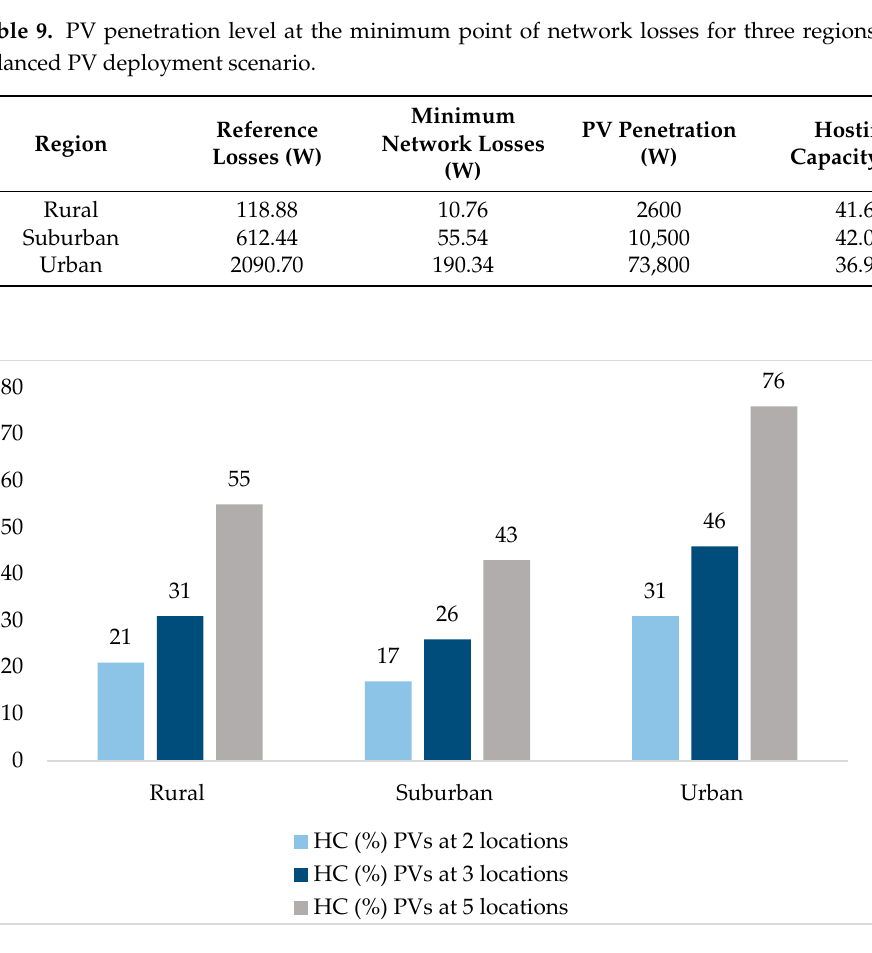
Table 10. Sensitivity analysis of economical hosting capacity in the cost analysis of three Finnish distribution networks by changing the cost of energy losses (ce) and load growth (r) by a factor of ± 5%, ± 10%, and ± 15%. ( a ). HC change with respect to the cost of energy losses deviation. ( b ). HC change with respect to load growth deviation.